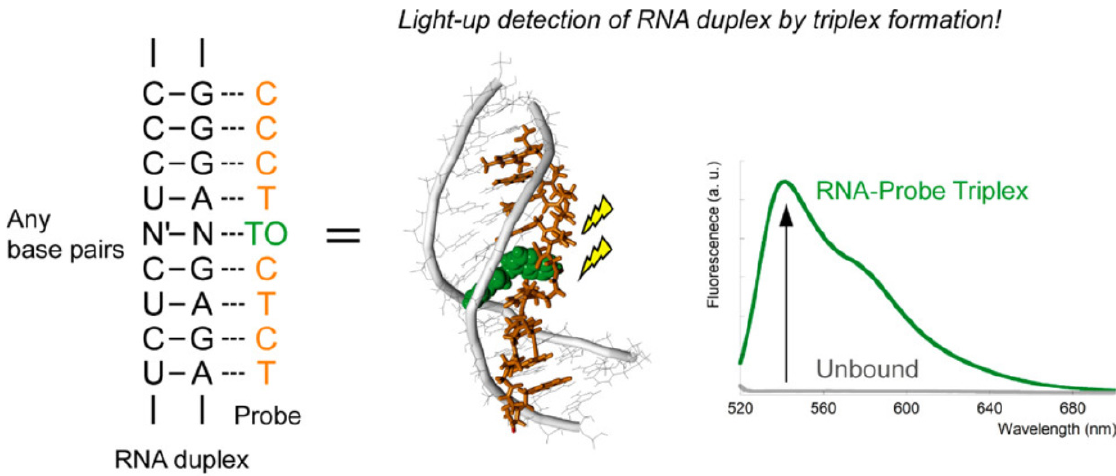
Figure 8. Binding of single-stranded peptide nucleic acid (ssPNA) TO modified probe to an RNA duplex motif forms a selectively fluorescent triple helix (triplex) structure.